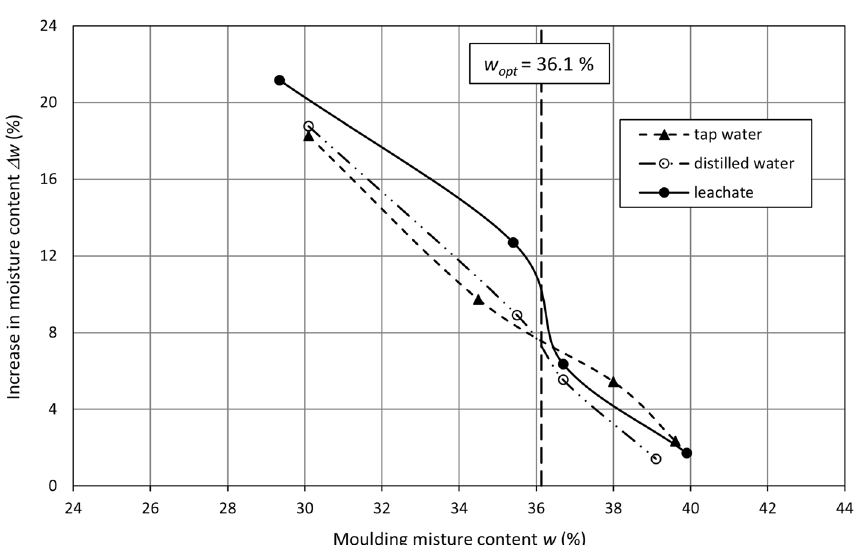
Figure 6. Moisture content increase versus moulding moisture